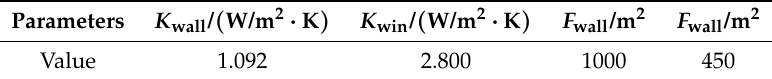
Table 1. Parameters of